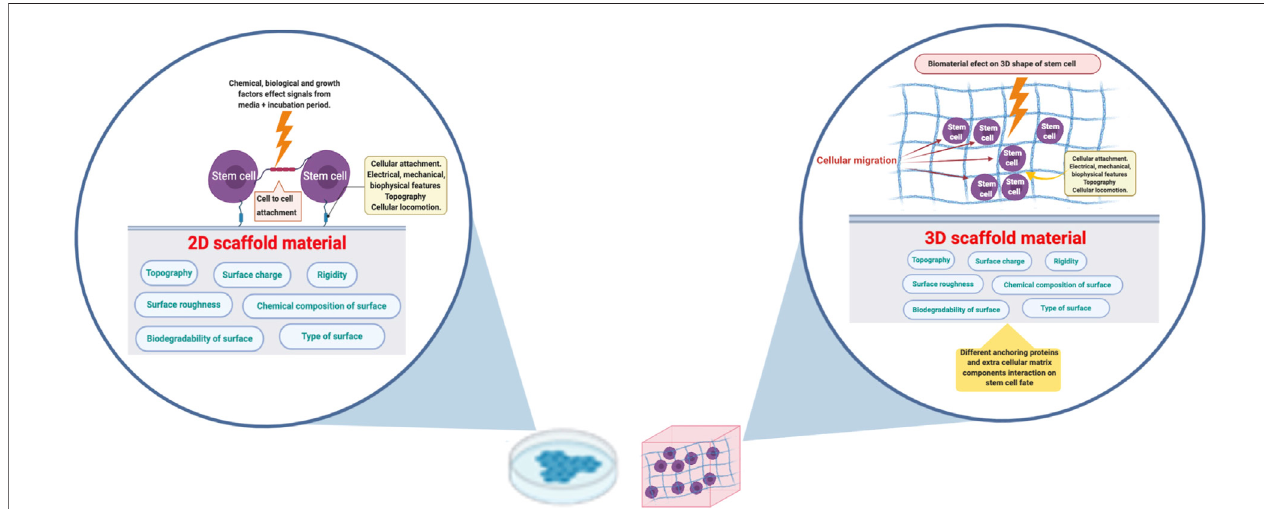
FIGURE 1 | Applying a biomaterial in 3D con fi guration would enhance the cell-cell and cell-material interaction. The biomaterial surface charge, roughness, topographyandchemicalcompositionwillaffectthecellsontheattachmentboundaryincaseof2Dculture.Cellsin3Dculturewillreceivethecorrespondingsignalsfrom the enclosing surroundings. The fi gure was created in